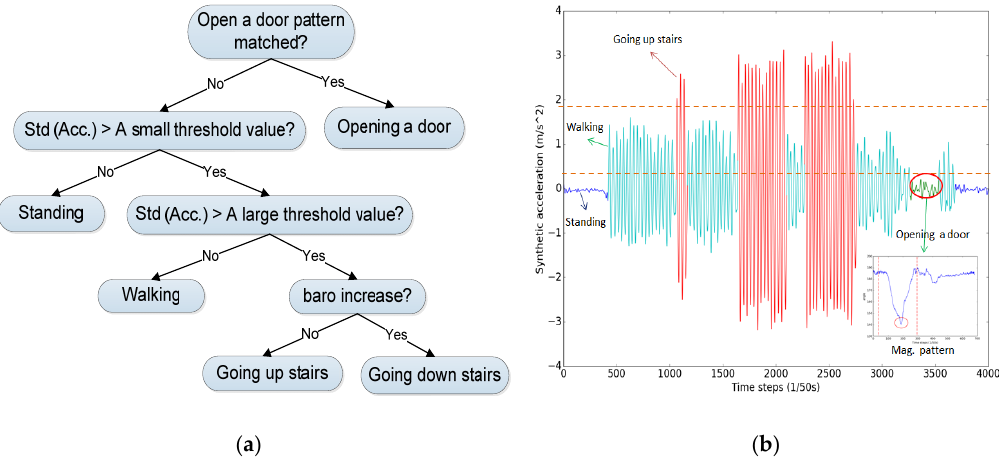
Figure 6. Using the DT algorithm to recognize activities. ( a ) Decision tree for HAR; ( b ) The classification process of a trajectory [5].